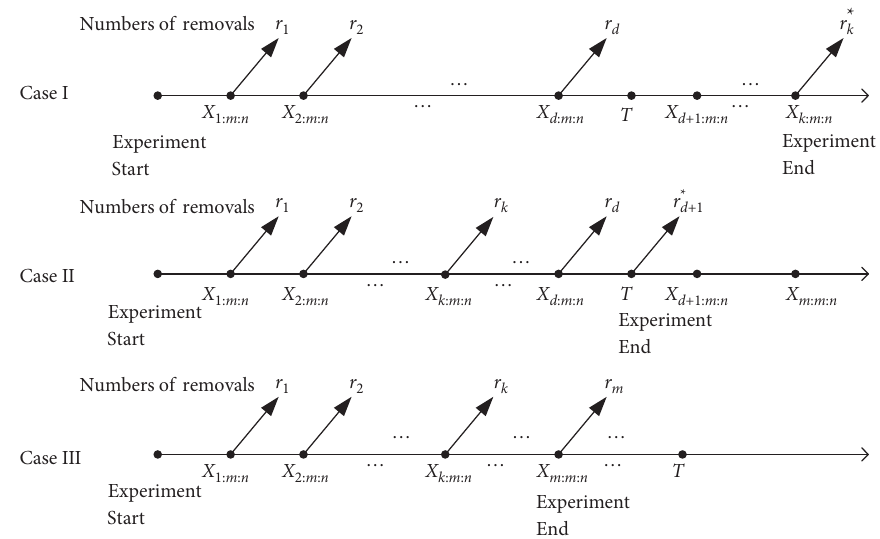
Figure 1: A sketch of the generalized progressive hybrid censoring